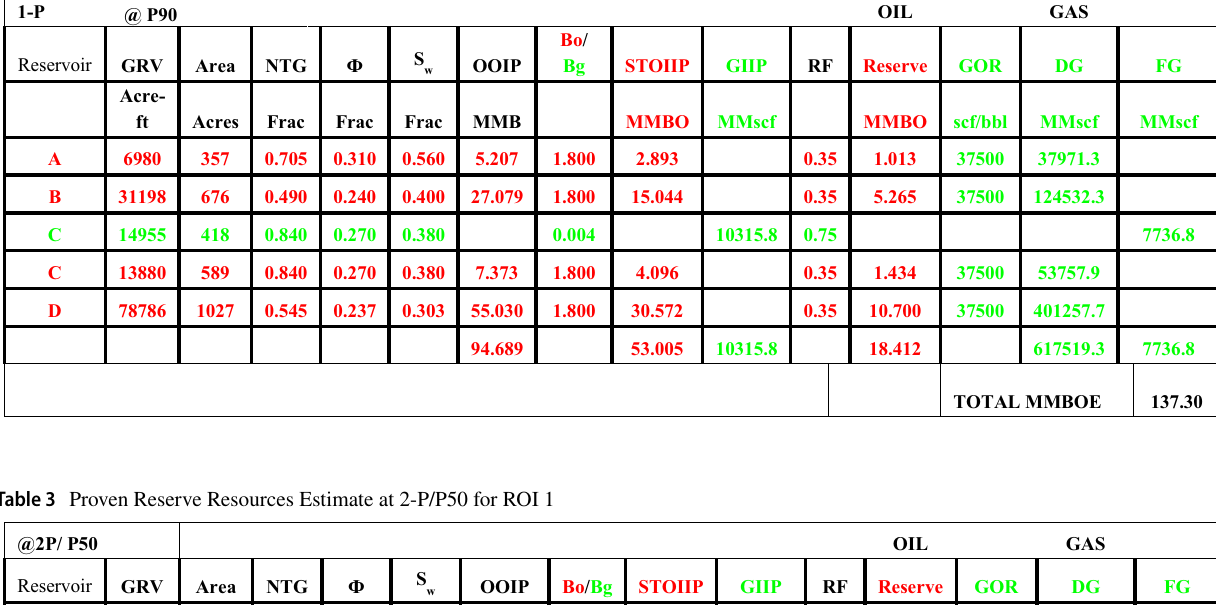
Table 2 Proven Reserve Resources Estimate at 1-P/P90 for ROI 1 1-P